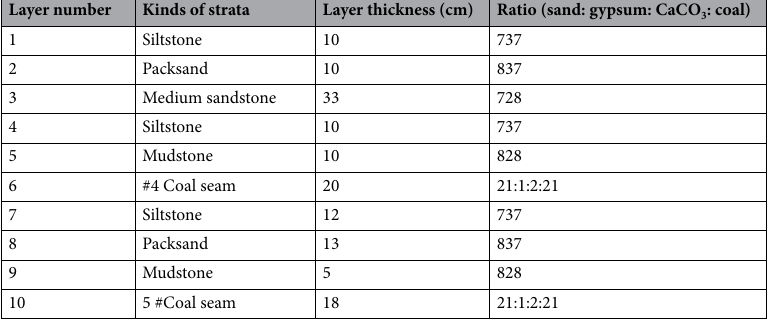
Table 2. Ratio of physical similar material simulation